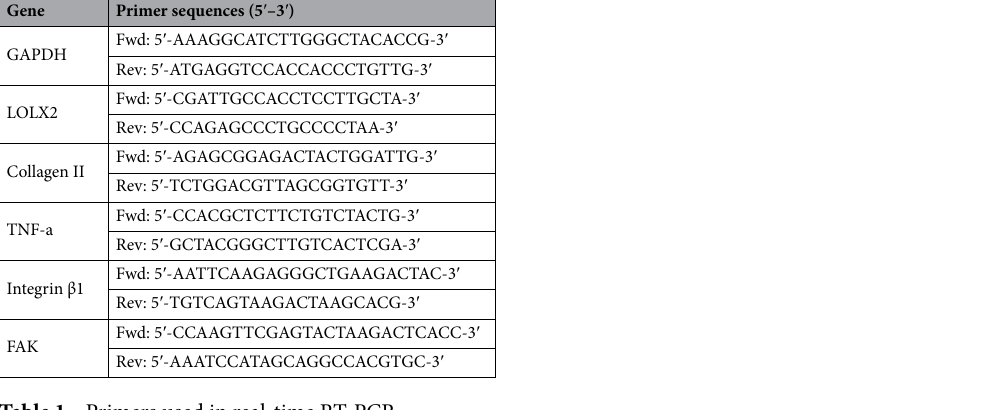
Table 1. Primers used in real-time